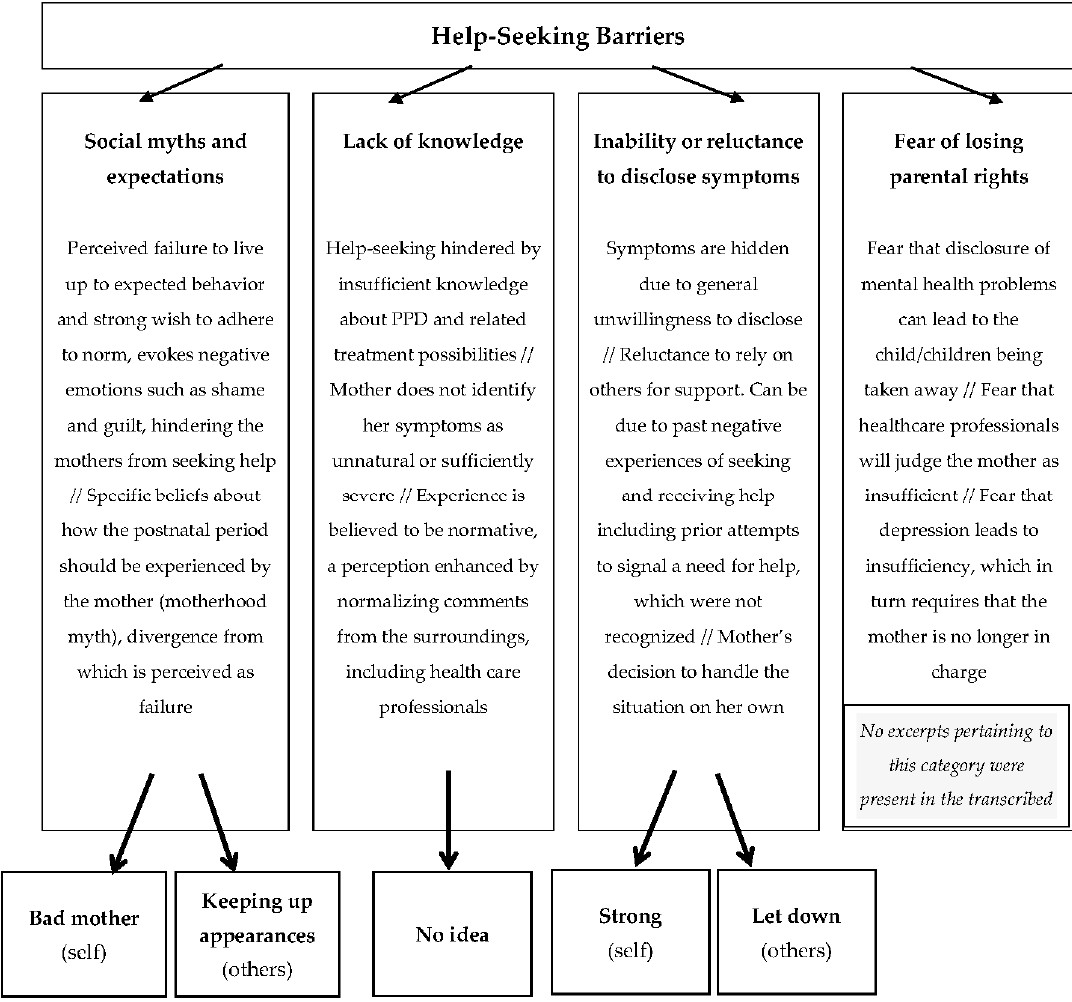
Figure 2. Links between the generic coding categories and the final categories.